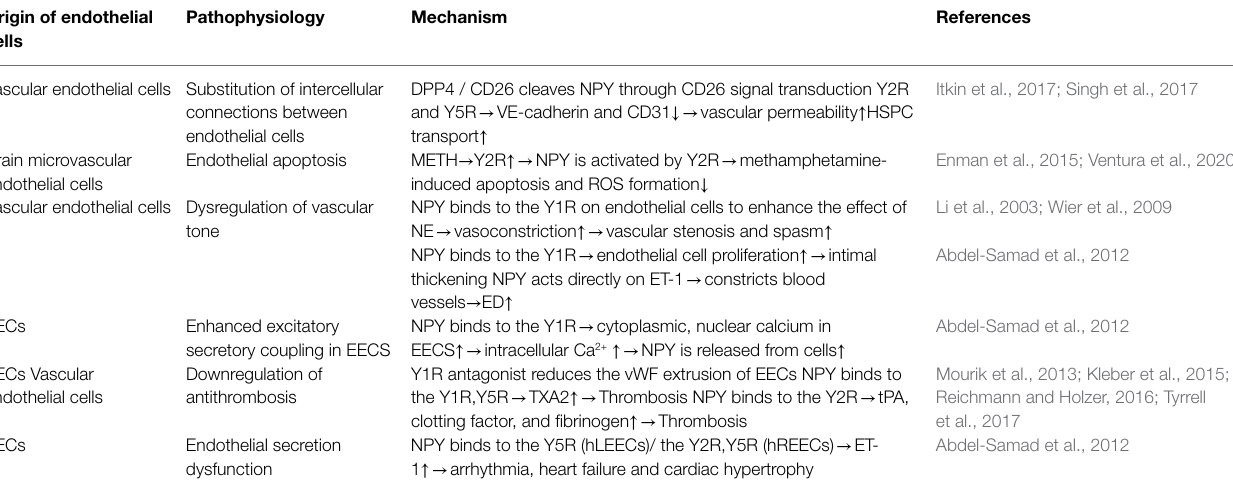
TABLE 2 | The direct role of NPY in